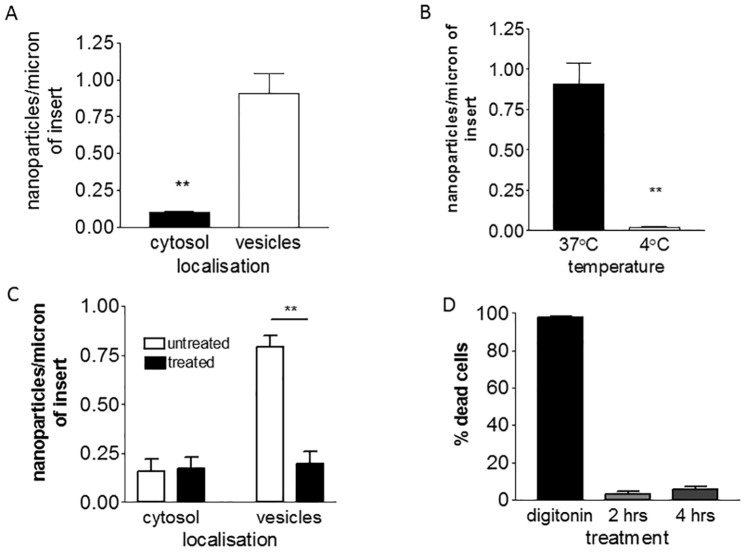
Uptake of PEG-amine/galactose gold nanoparticles by brain endothelial cells.(A) Localisation of nanoparticles at 3hrs (t-test, ** P<0.01). (B) Effect of temperature on nanoparticle uptake into vesicles at 3hrs (t-test, ** P<0.01). (C). Effect of inhibitors of active transport sodium azide/2-deoxy glucose on uptake of nanoparticles at 2 hrs (one-way ANOVA, Tukey’s post test ** P<0.001). (D) Cell membrane integrity/viability test after treatment with sodium azide/2-deoxy glucose, for 2 or 4hrs. Digitonin is a positive control for cell death. All bars show mean ± SEM and are all based on 3-independent experiments.